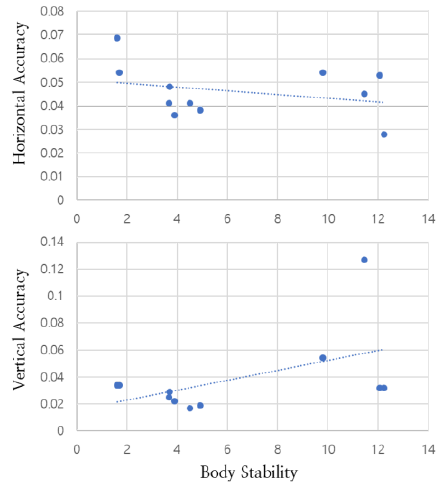
Figure 8. Relationship between body stability and accuracy of bundle adjustment